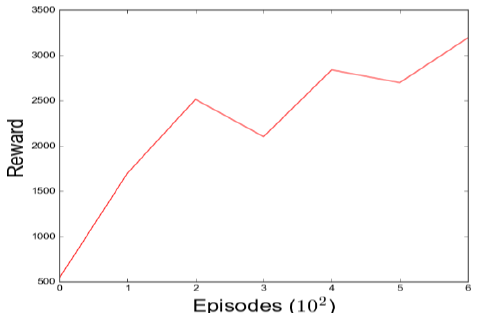
Figure 12. Average cumulative reward obtained by a DQN agent in the Gazebo simulator.